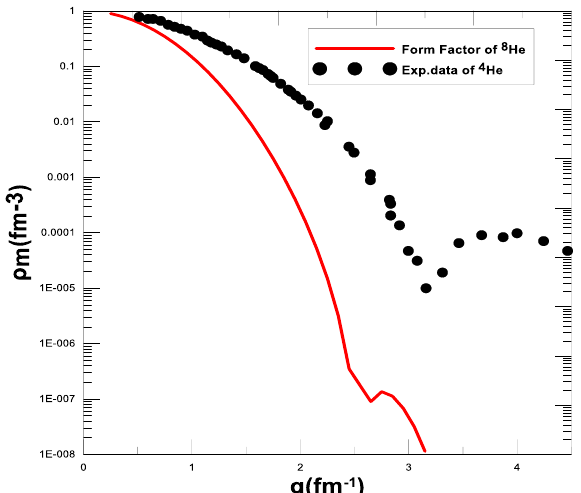
Figure 6: Comparison between the calculated elastic form factors of 8 He and the experimental data of stable 4 He